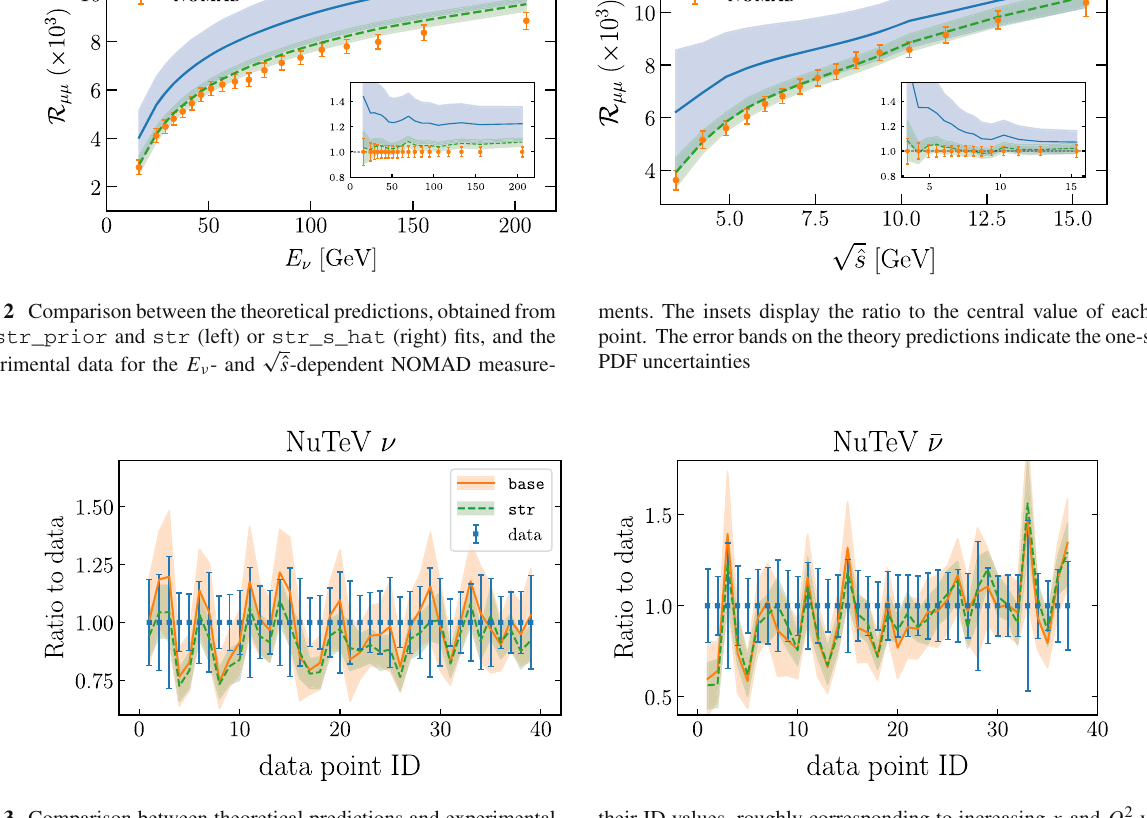
their ID values, roughly corresponding to increasing x and Q 2 values (for fixed pseudo-rapidity bins y ) when the plots are read from left to